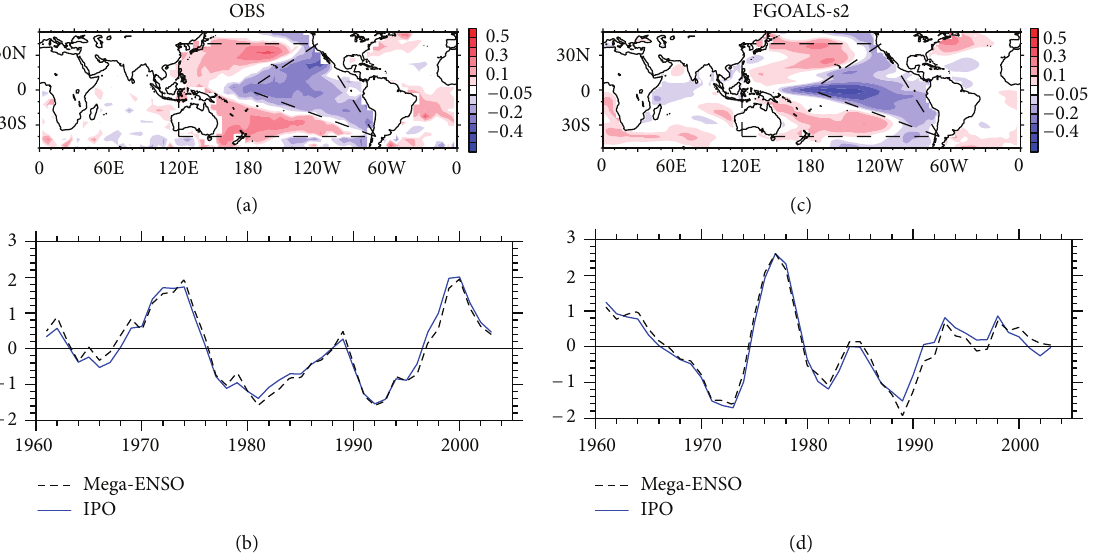
Figure 9: Left panel: the spatial pattern of IPO mode in the observation (a) and corresponding time series (blue line in (b)). The IPO mode is defined as the second EOF mode of 4-year running-averaged annul near global SST (50 ∘ S–50 ∘ N). The black line in (b) is Mega-ENSO index, defined as the difference in the SST anomalies between the western K-shape zone and eastern triangle zone in (a). Right panel: the same as the left panel, but for the FGOALS-s2.